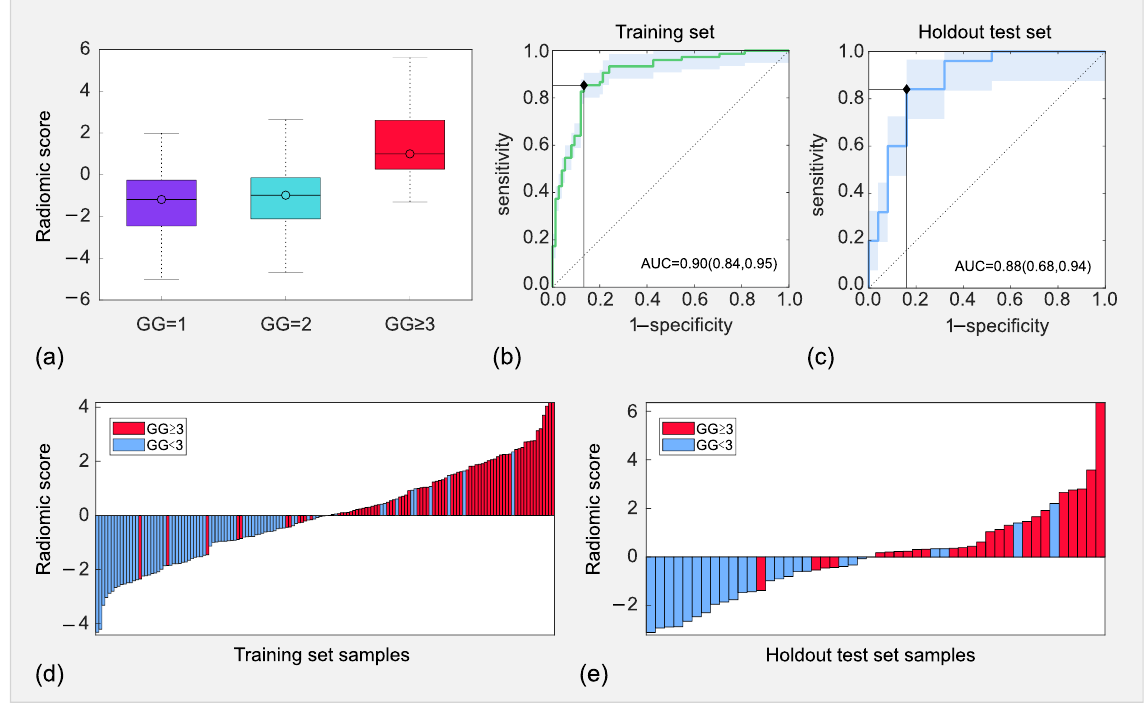
Figure 4. Boxplot of discrimination achieved by the radiomic score among the three Gleason Grade groups (GG)1, GG2, and GG ≥ 3 ( a ). receiver operating characteristic (ROC) curves achieved by the radiomic model in the training ( b ) and test ( c ) sets and waterfall plots achieved by the radiomic model in the training ( d ) and test ( e )